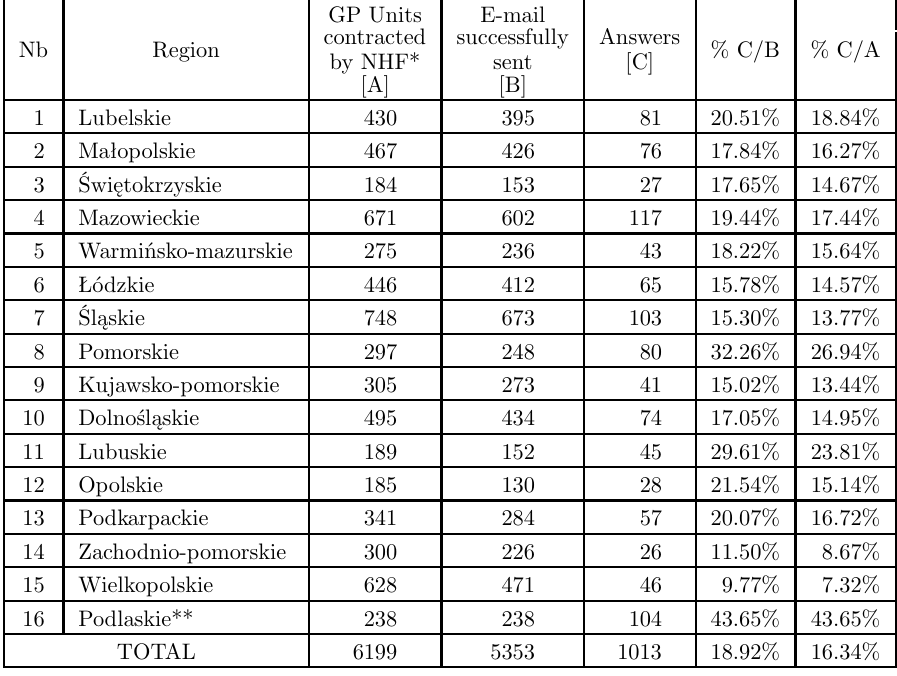
Table 1. Responses obtained in the National Study of ICT Use in Primary Healthcare in Poland GP Units E-mail contracted successfully Answers